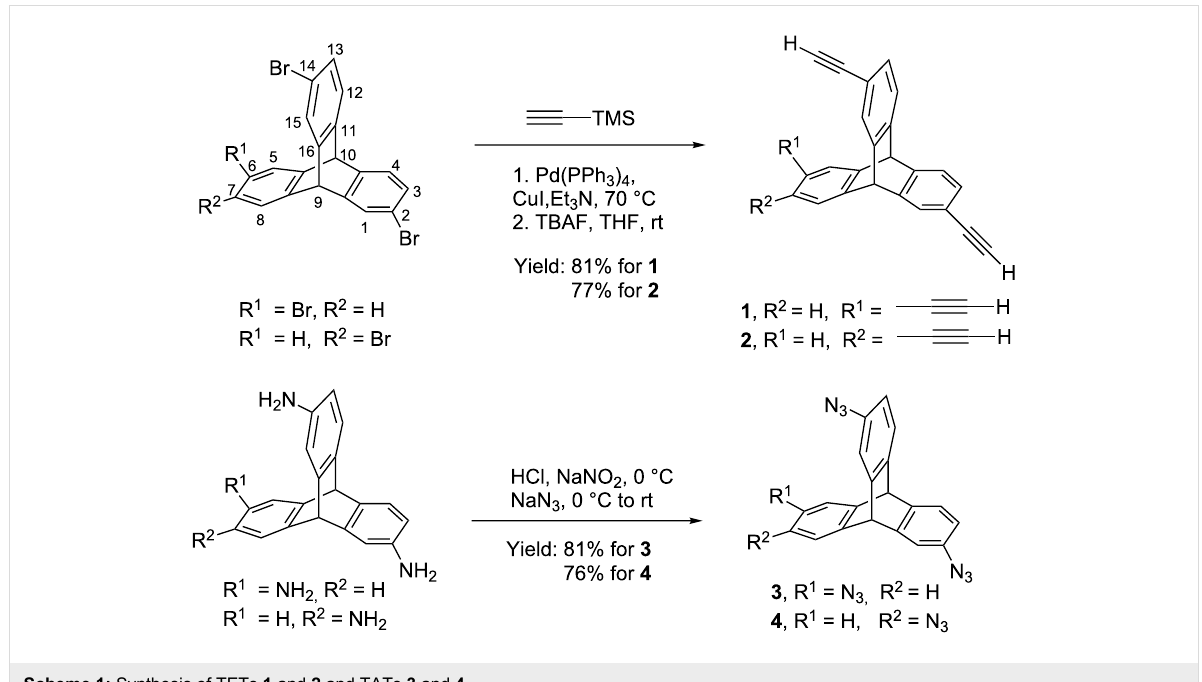
Scheme 1: Synthesis of TETs 1 and 2 and TATs 3 and 4